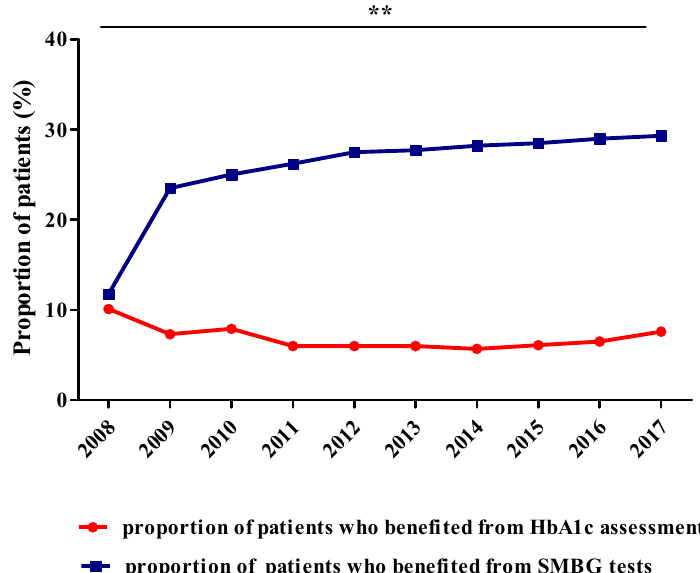
Figure 5. Evolution of the number of patients who benefited from HbA1c assessments or SMBG tests (adults and children) (r = − 0.781, ** p = 0.008).